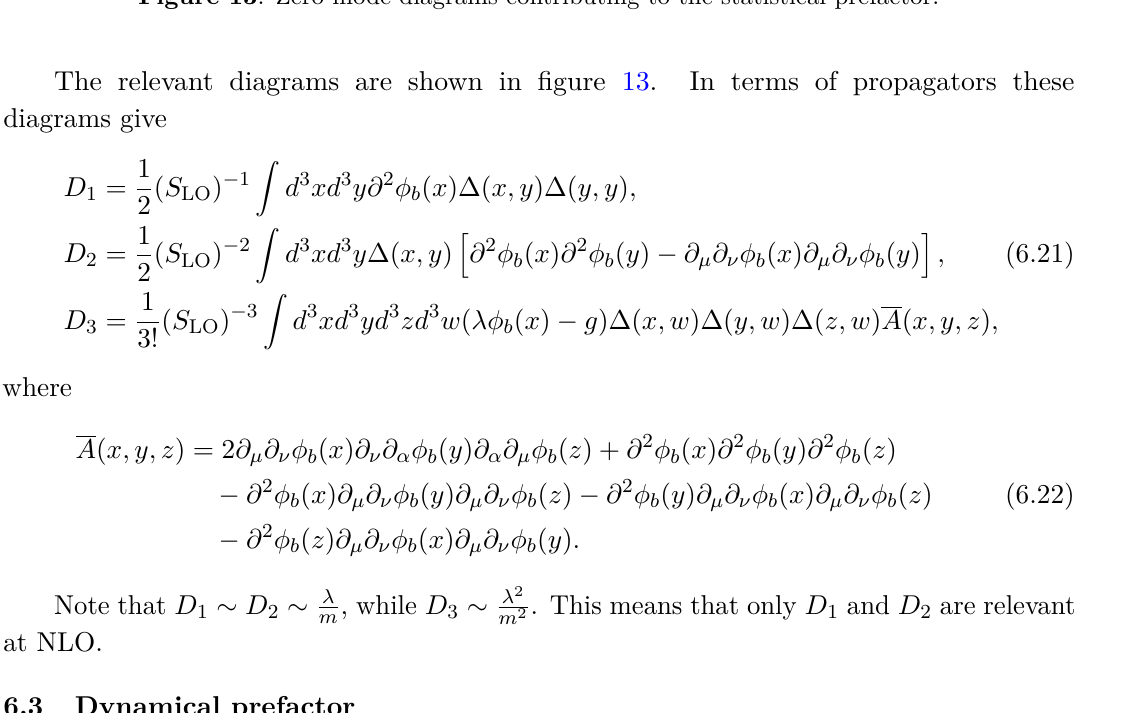
Figure 13 . Zero-mode diagrams contributing to the statistical